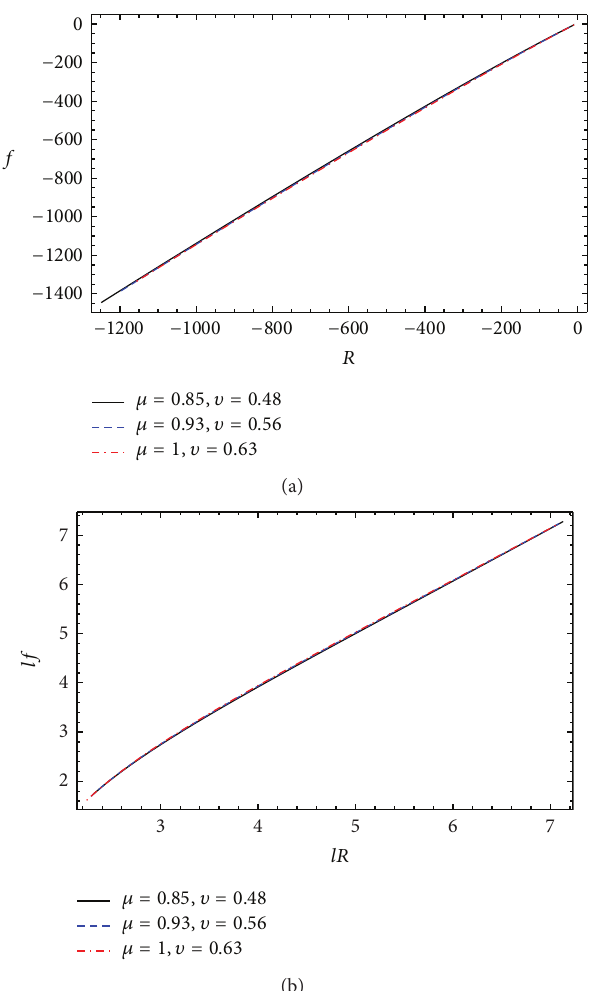
0.63𝜇 = 0.93 , 𝜐 = 𝜇 = 1 , 𝜐 = Figure 11: Future evolution of 𝑅 in NHDE with −1 ⩽ 𝑧 ⩽ 1